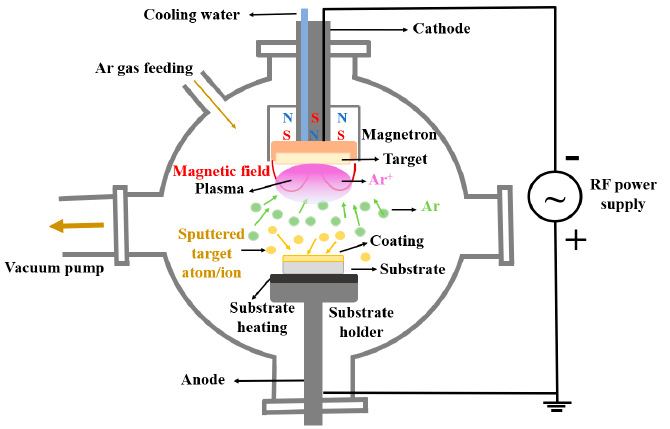
Figure 1. Schematic representation of RF-MS experimental setup.